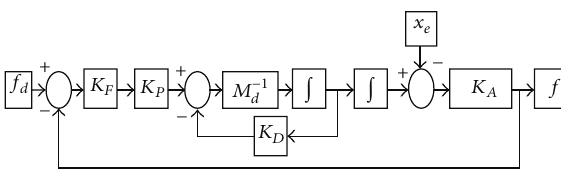
Figure 12: Joint 0.